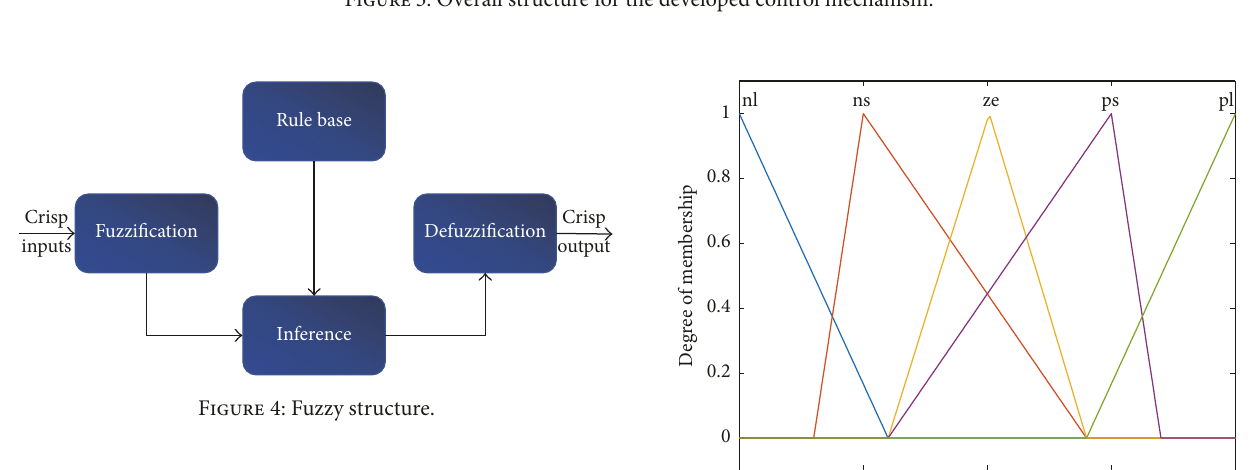
Figure 3: Overall structure for the developed control mechanism.